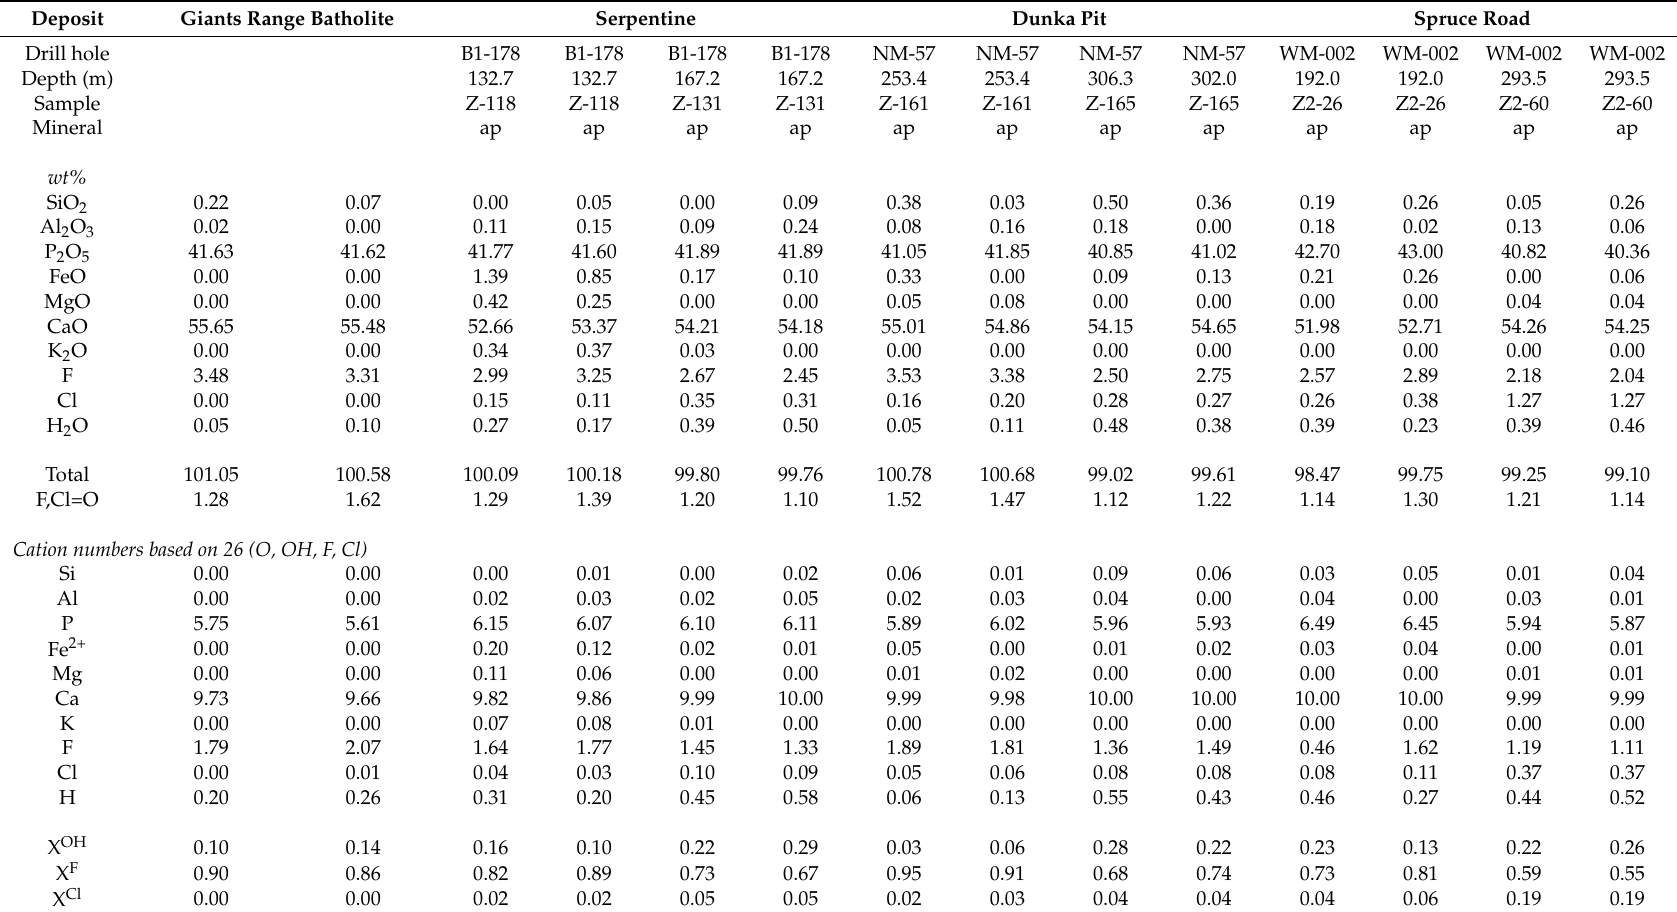
Table 4. Representative electron microprobe analyses of apatite